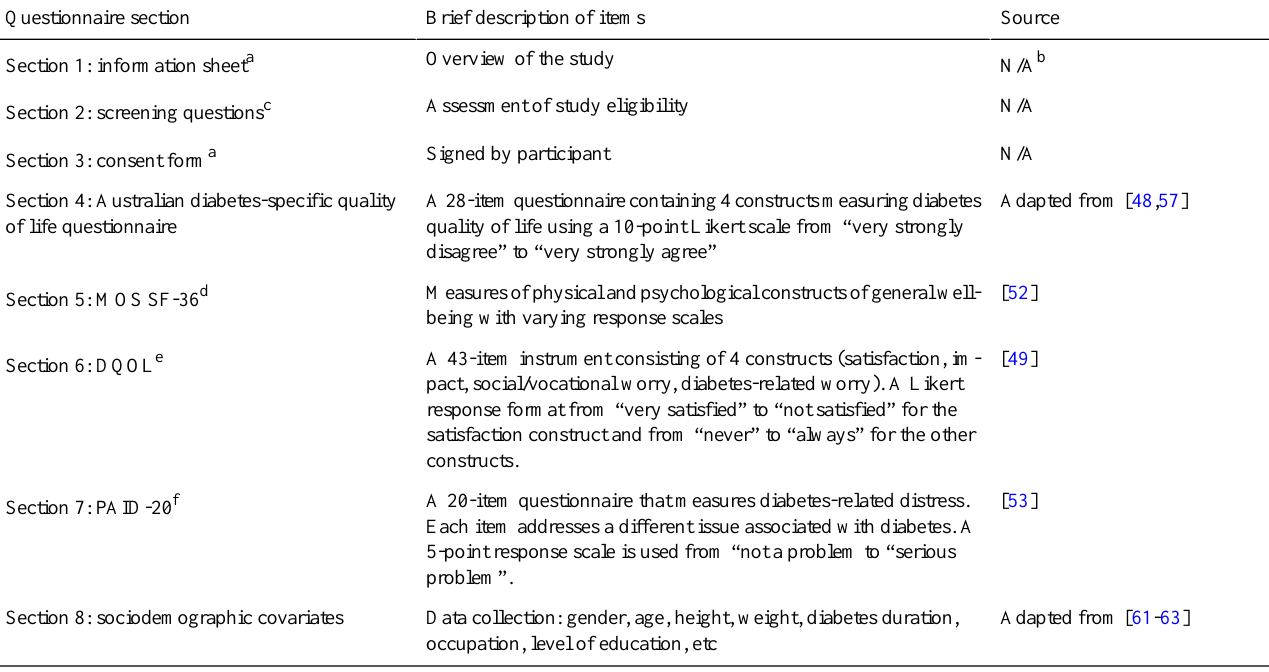
Table 3. Study phase 2b–subsequent validation: online Australian diabetes-specific quality of life, MOS SF-36, DQOL, and PAID-20 questionnaires completed by adults with type 1 diabetes mellitus